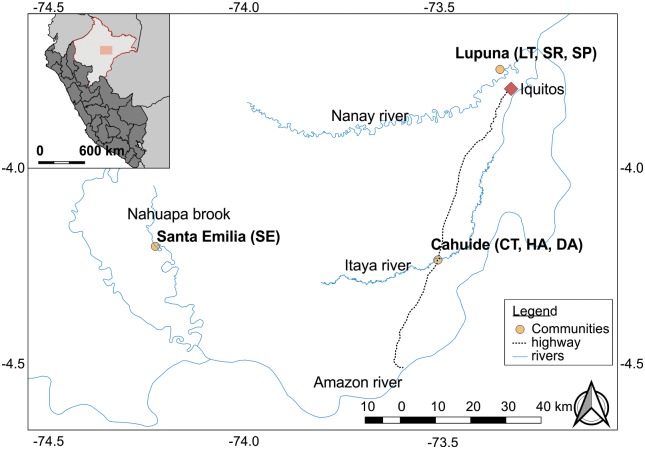
Map of the study sites.The map represents the three study areas included in this study. Lupuna (LUP) englobe three contiguous villages Santa Rita (SR), San José de Lupuna town (LT), and San Pedro (SP); Cahuide is composed by La Habana (HA), Doce de Abril (DA) and Cahuide town (CT); and Finally, Santa Emilia (STE) just include a town of the same name (SE). The Map was produced using QGIS Development Team 2.18.14 (2018), and the base map was obtained from The USGS Global Visualization Viewer GloVis (http://glovis.usgs.gov/), under CC BY 4.0.